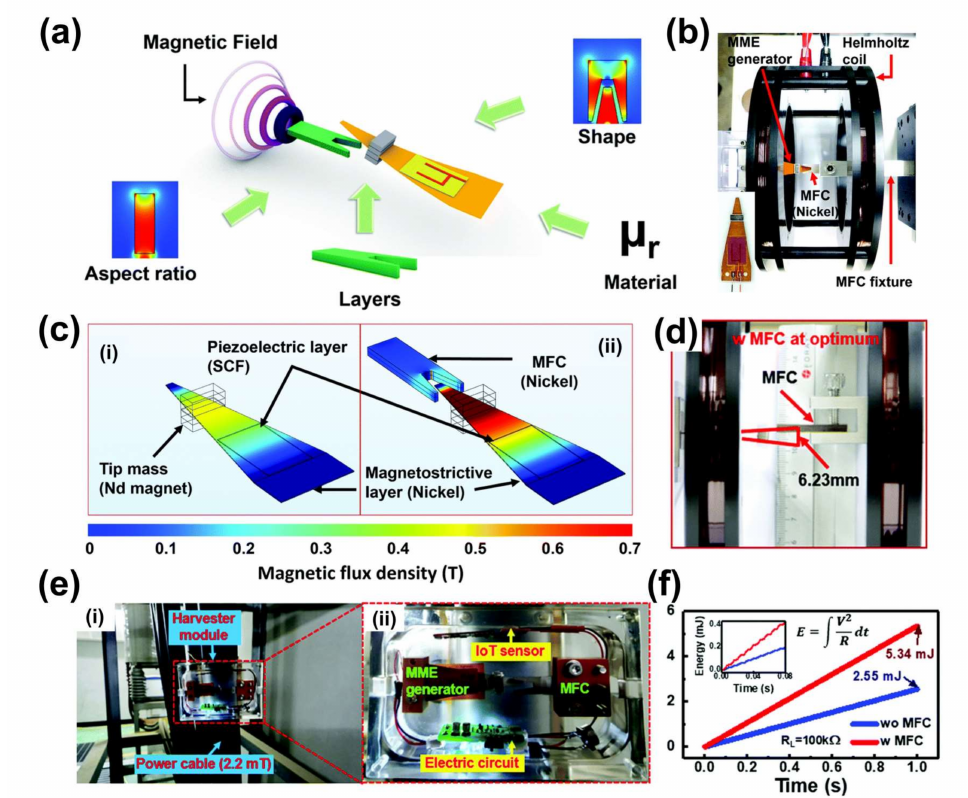
Figure 7. ( a ) Schematic diagram of MFC concentrating stray magnetic field on MME generator with shape, material, layers, and aspect ratio. ( b ) Measurement set-up of MME generator with MFC ( c ) Magnetic flux density distribution in magnetostrictive layer of MME generator with MFC ( i ) and without MFC ( ii ). ( d ) Optimization of MFC location over thickness of MME generator under 8 Oe. ( e ) Photocopy of energy harvesting from a power cable at substation using MFC harvested module. ( f ) Harvested energy response at optimum load resistance of 100 k Ω with and without MFC. Reproduced with permission